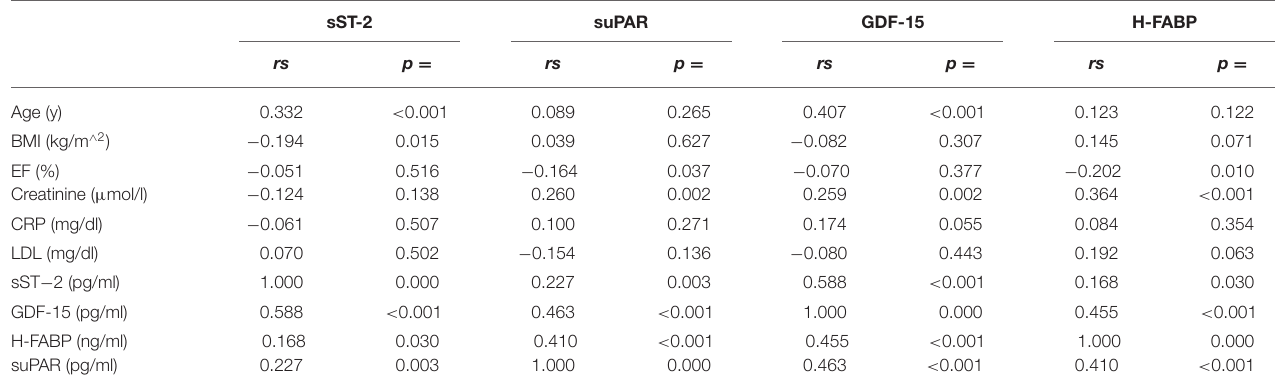
TABLE 2 | Bivariate correlation and point-biserial correlation analysis of baseline characteristics and biomarkers.